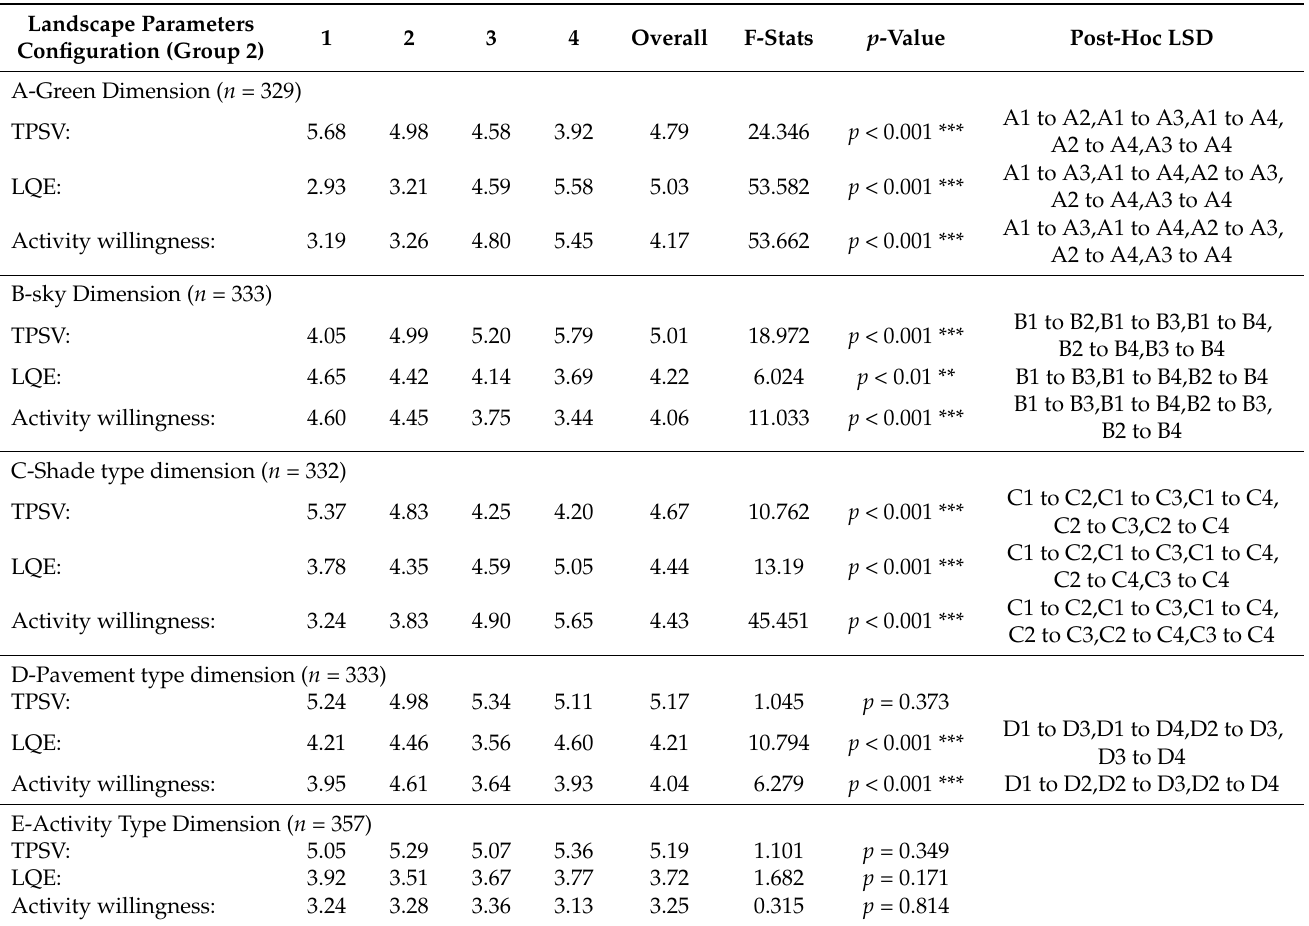
Table 8. TPSV means and ANOVA analysis and LSD post hoc test for different landscape